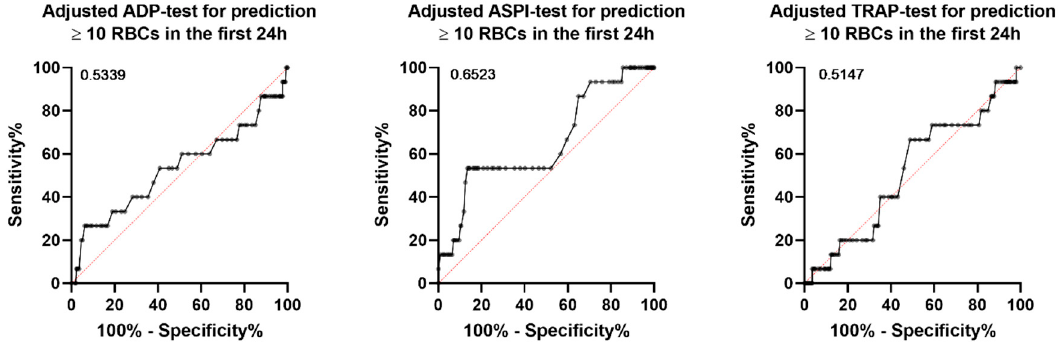
Figure 2. ROC curves for transfusion of ≥ 10 RBCs within 24 h adjusted for platelet count. ADP, adenosine diphosphate; ASPI, arachidonic acid test; TRAP, thrombin-receptor-activating peptide; ROC, receiver operating characteristics.